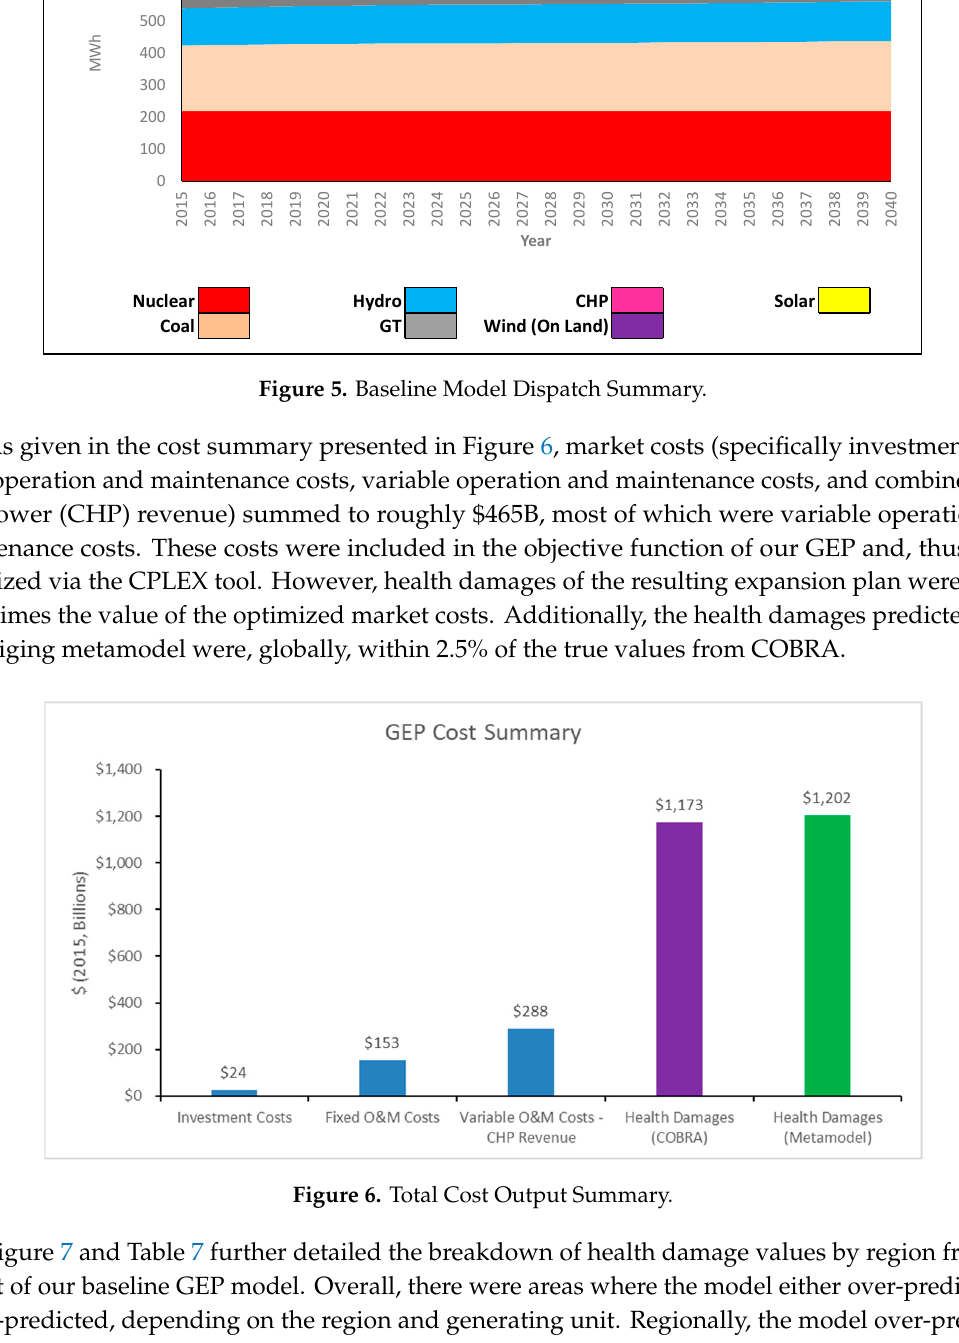
Table 6. Baseline Model Investment Strategy.